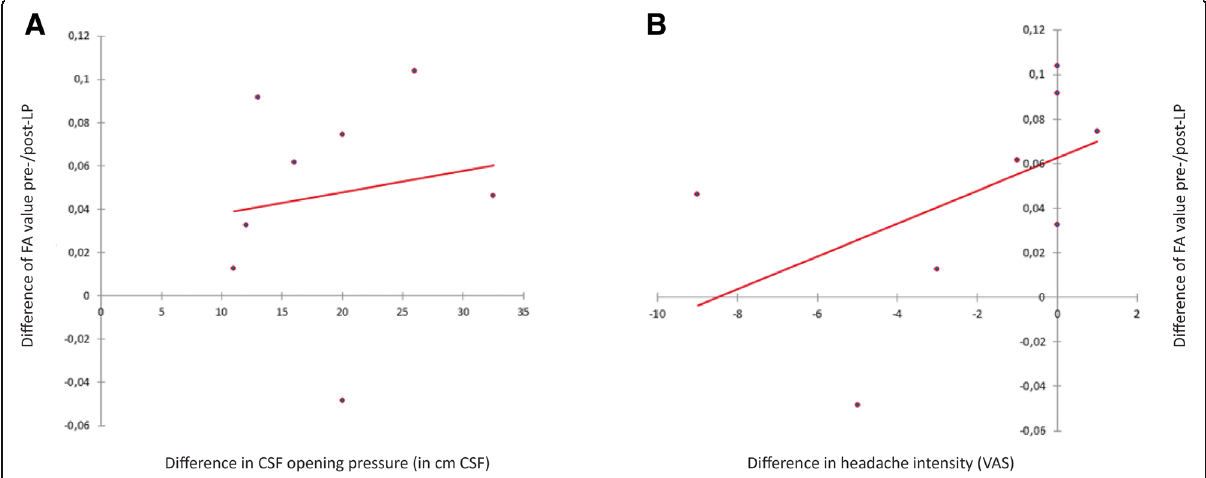
within the observation period of 26 h (Table 2). In